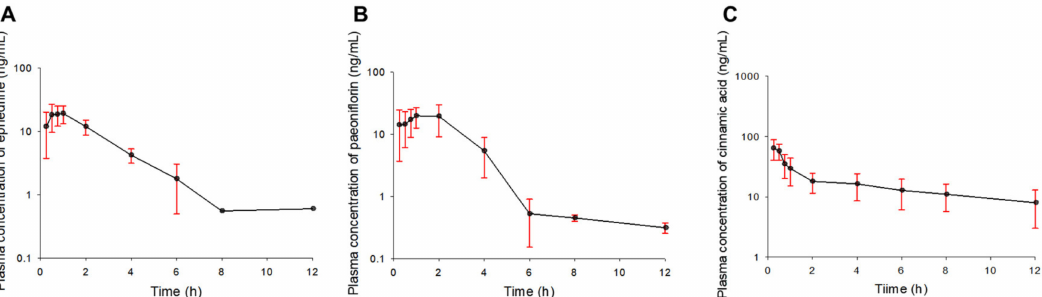
Figure 2. Mean plasma concentration–time profiles of ephedrine ( A ), paeoniflorin ( B ), and cinnamic acid ( C ) obtained after the single oral administration of Socheongryong-tang (SCRT) to rats ( n = 5). The vertical bars represent standard deviations.